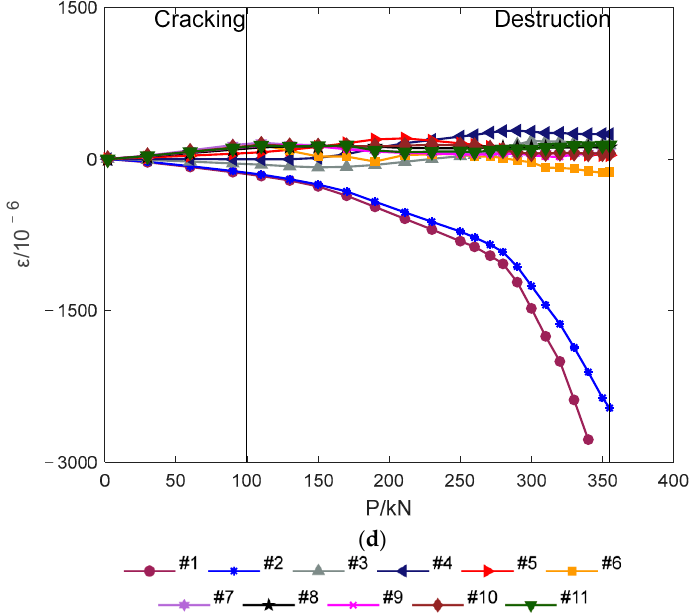
Figure 10. Strain development of concrete in specimens ( a ) Specimen PRS400A1. ( b ) Specimen PRS400A2. ( c ) Specimen PRS400B1. ( d ) Specimen PRS400B2.